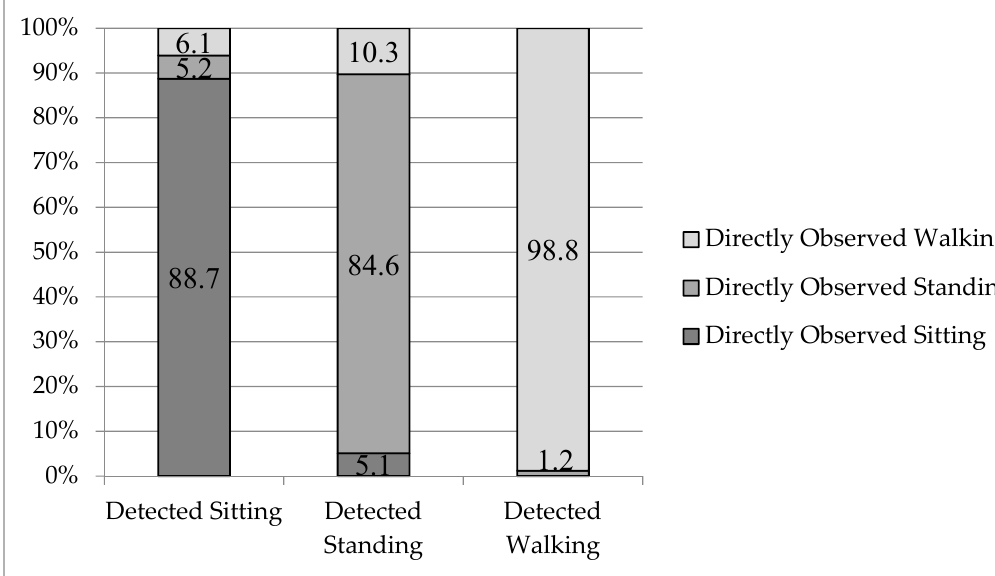
Figure 5. ActiGraph detections and the proportion of actual underlying behaviors.